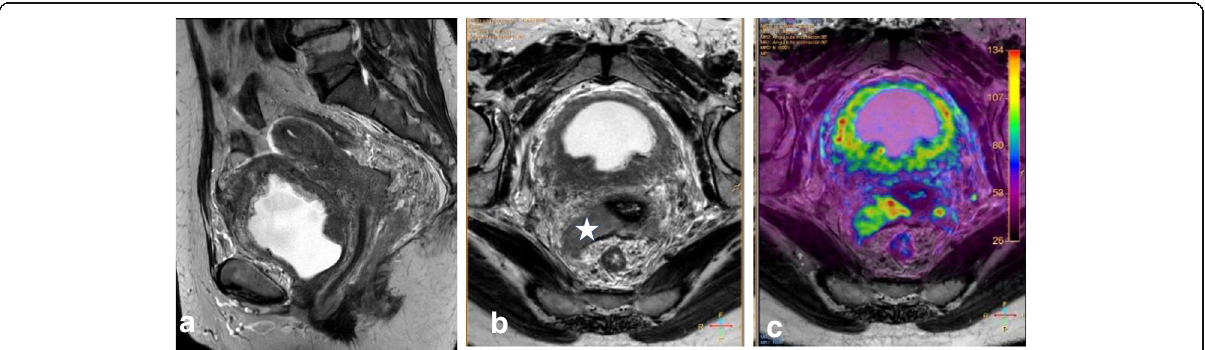
Fig. 22 Transitional bladder cancer invading the cervix (star), visualized by sagittal T2WI ( a ), axial oblique T2WI ( b ), and T2WI+DWI ( c )